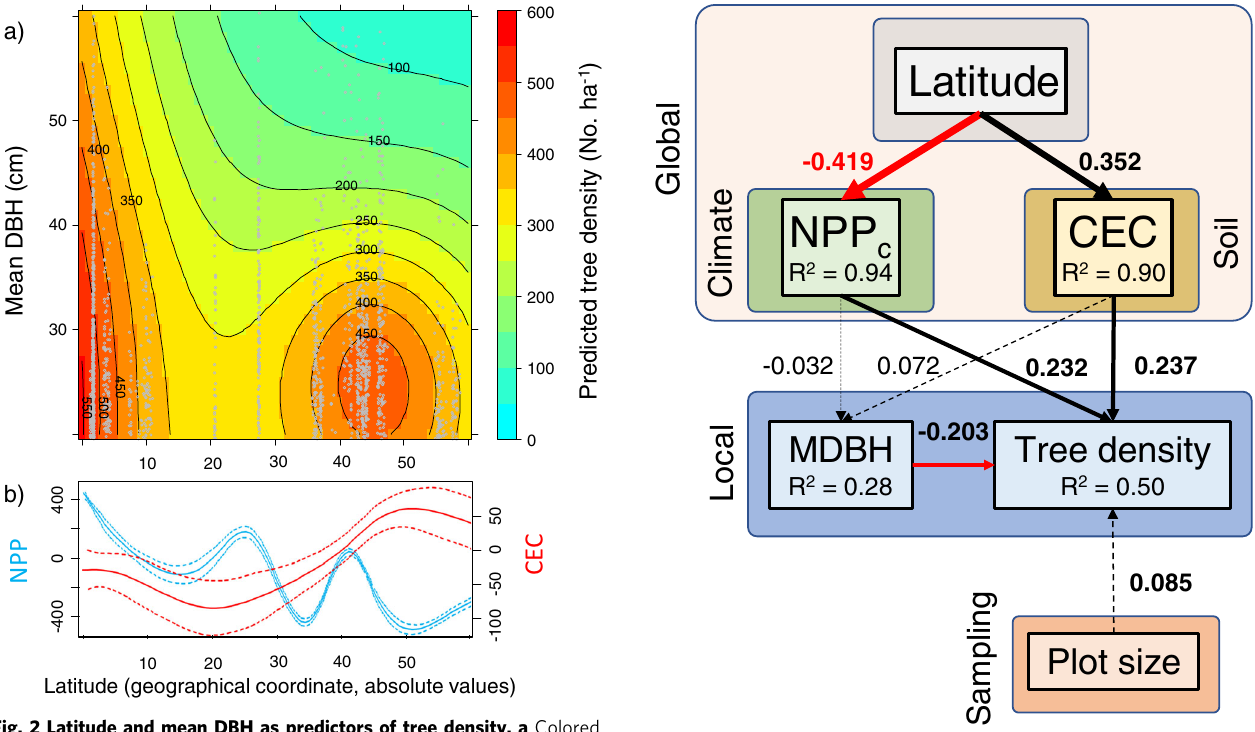
Fig. 2 Latitude and mean DBH as predictors of tree density. a Colored contour biplot for predictions of a generalized additive mixed model (GAMM) in which tree density (see the colored scale on the right) is expressed as a function of mean DBH (diameter at breast height) and latitude. Gray points are the data used in the GAMM. b predicted smoothing values of climatic Net Primary Productivity (NPP, blue lines) and Cation Exchange Capacity (CEC, red lines) as function of latitude. Solid lines represent the fi tted mean values whereas dotted lines represent the 95% con fi dence intervals around the